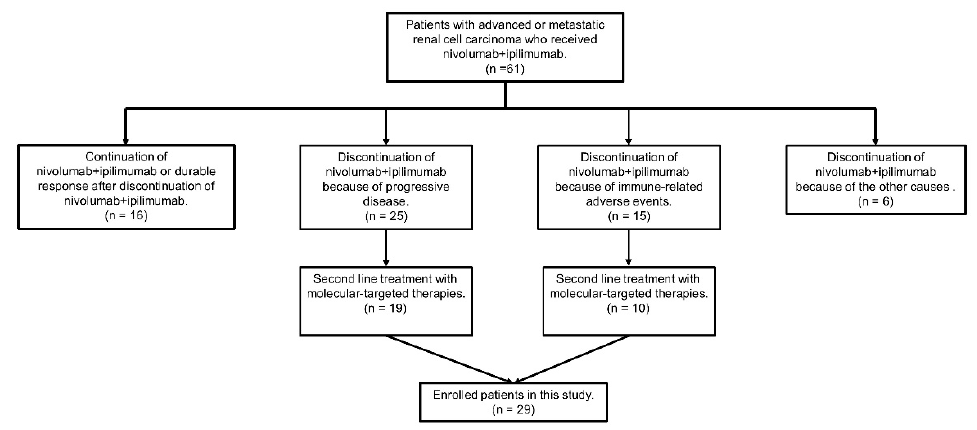
Figure 1. Flowchart of study population selection. Table 1. Patient demographics at the time of the first molecular-targeted therapy in patients who discontinued nivolumab and ipilimumab combination therapy.